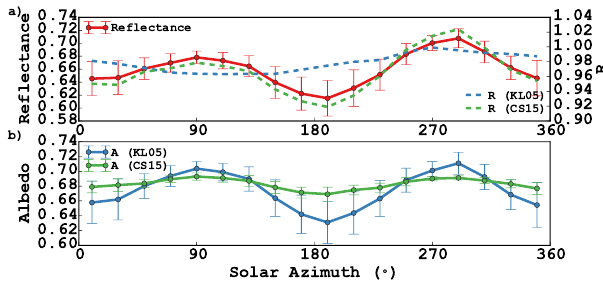
Figure 7. (a) Mean CERES reflectance (red line, left scale) in 20 ◦ φ 0 bins for the region 88–89 ◦ S, 76–83 ◦ W over all Decembers from 2000 to 2004. The viewing geometry range of the measurements is (for relative azimuth, viewing zenith, and solar zenith, respectively), 65 ◦ φ< 75 ◦ , 45 ◦ <θ< 65 ◦ , and 65 ◦ <θ 0 < 70 ◦ . The dashed blue line shows the mean anisotropic factor (right scale) used to invert these reflectances into fluxes from the KL05 ADMs. The dashed green line shows the same but for the ADMs developed here (CS15). (b) Mean CERES albedo for the same region and viewing geometry in . v ,φ (a) for the KL05 ADMs (blue) and CS15 ADMs (green line). Error bars represent 1 standard